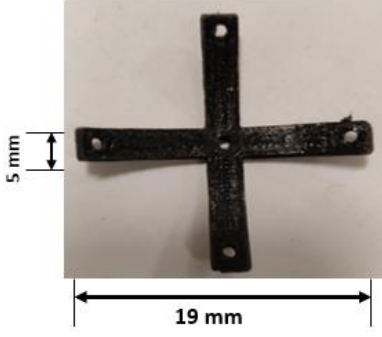
Figure 8. Origami capsule